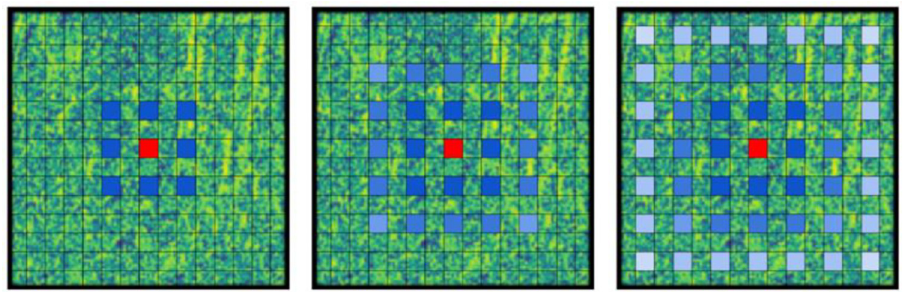
Fig 5. Covering effect of three-layer atrous convolution with equal atrous